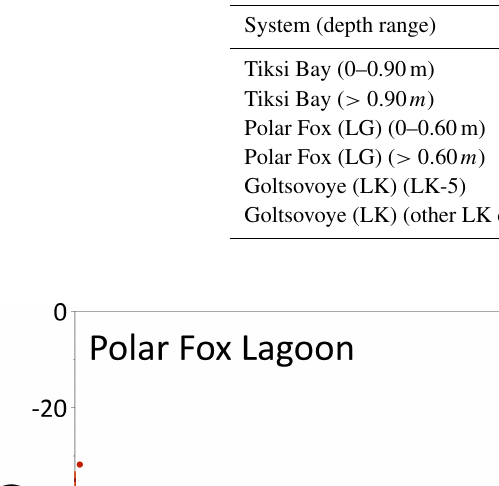
Table 3. Regression lines of the δ 18 O-versus- δ D plot for the three systems (Fig. 8).